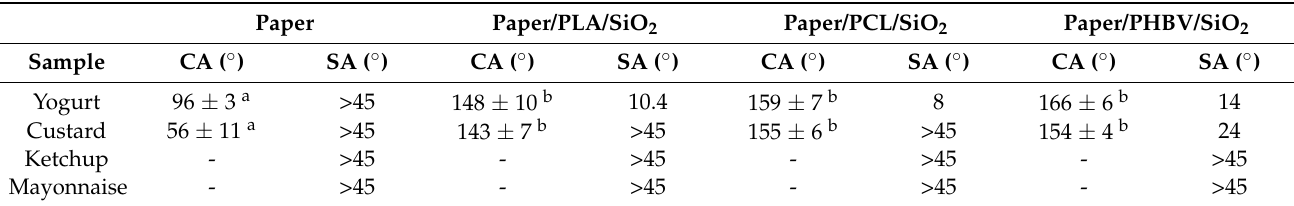
Table 7. Contact angle (CA) and sliding angle (SA) for yogurt, custard, ketchup, and mayonnaise of the uncoated paper and the multilayer structures based on paper, electrospun polylactide (PLA), poly( ε -caprolactone) (PCL), and poly(3-hydroxybutyrate-co-3-hydroxy-valerate) (PHBV) mats, and electrosprayed hydrophobic silica microparticles of Paper/PLA/SiO 2 annealed at 160 ◦ C, Paper/PCL/SiO 2 annealed at 55 ◦ C, and Paper/PHBV/SiO 2 annealed at 120 ◦ C. For ketchup and mayonnaise, the contact angle could not be